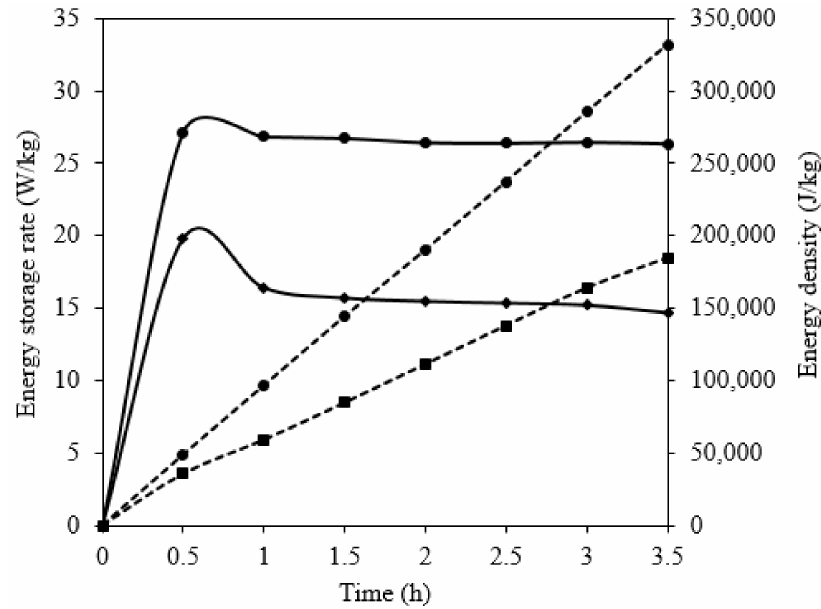
Figure 18. Comparison of energy storage rate and density during charging.